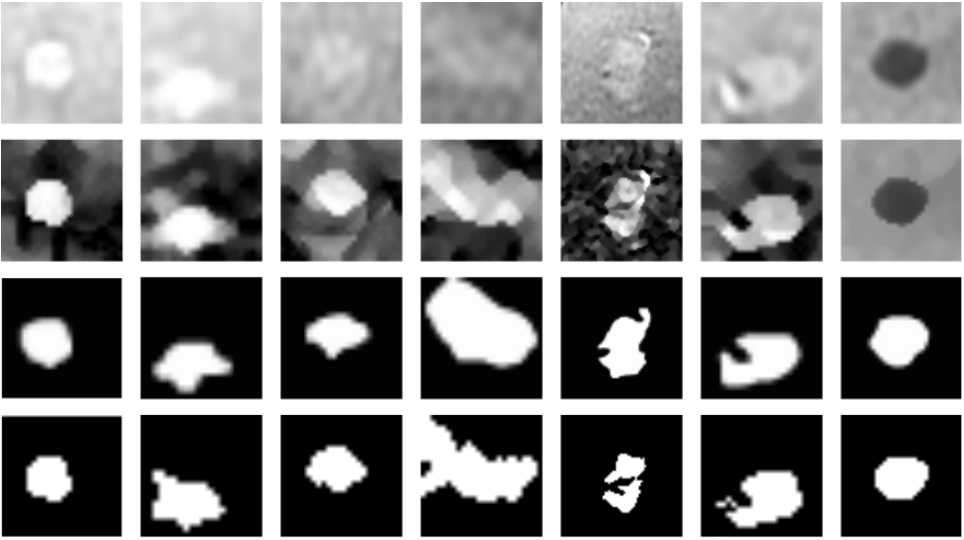
Figure 11. Segmentation results of HCC, from top to bottom: ROI selected by an expert; smoothed shock filter applied on these images; ground-truth of tumors’ contours; and segmentations obtained with our